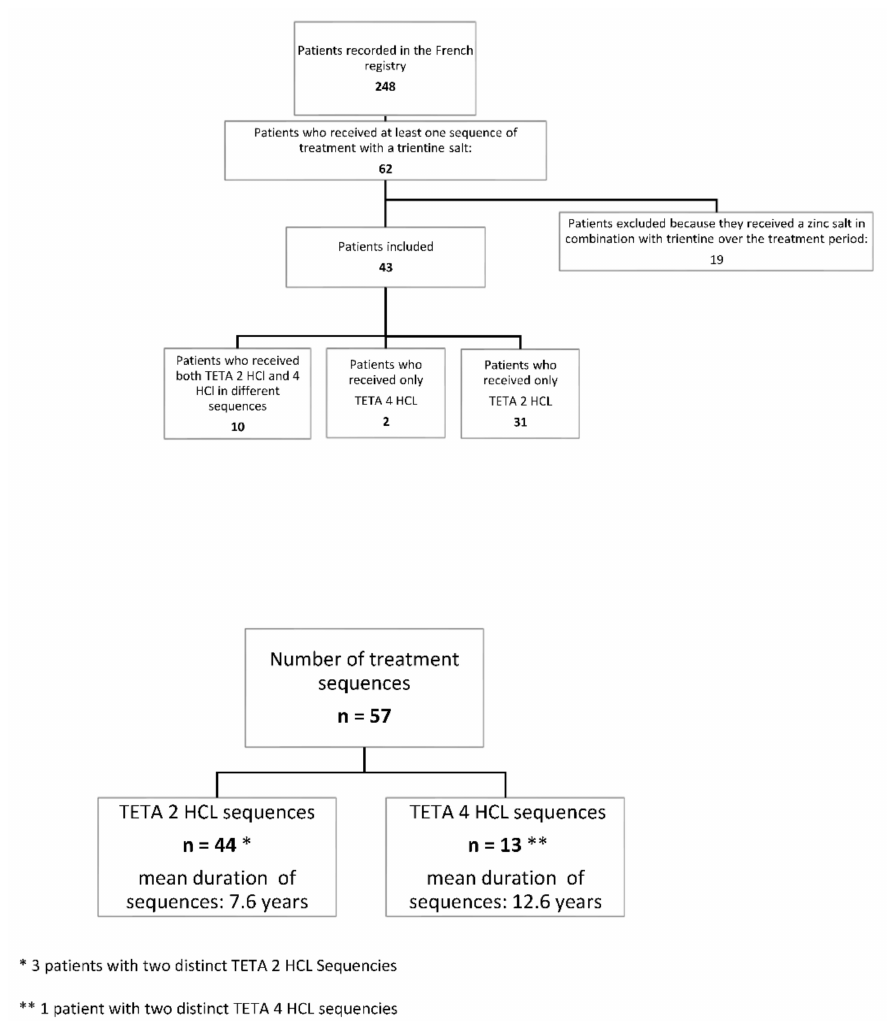
Figure 1. Flow-chart of patients included and treatment sequences. Table 1. Baseline characteristics at Trientine sequence